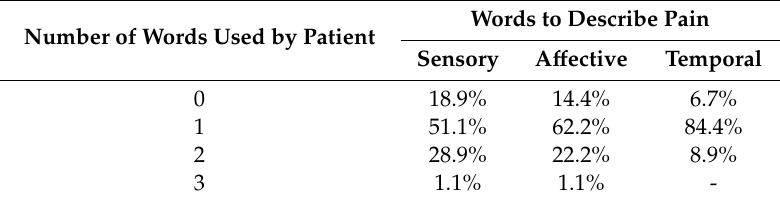
Table 4. Percentage of patients reporting di ff erent words to describe their pain during pain crisis.